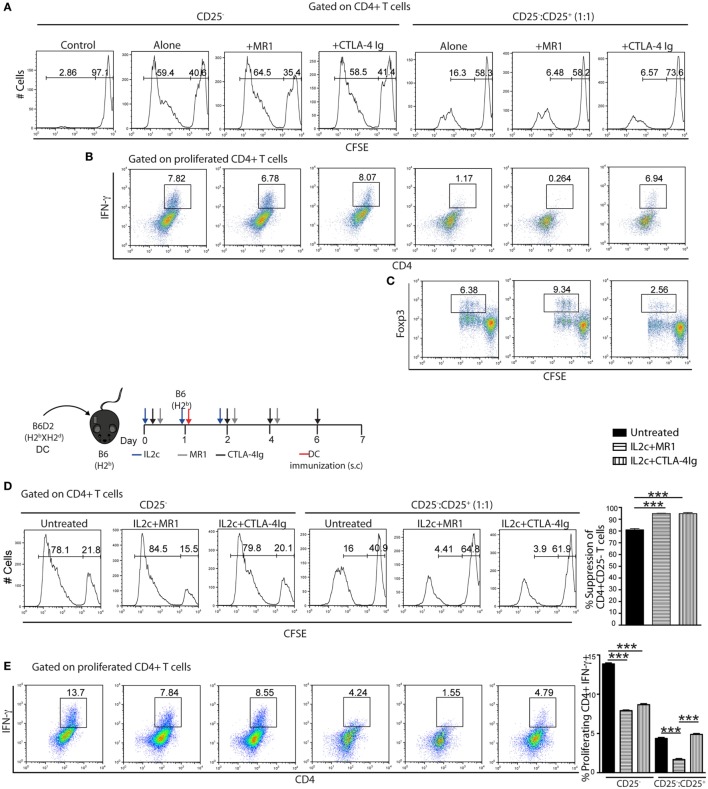
Suppressive function of IL2c-expanded Treg in the presence of co-stimulation blockade. (A–C) CD4+CD25− (CD25−) and CD4+CD25+ (CD25+) T cells were isolated from naïve B6 mice. CFSE-labeled CD25− cells (1 × 105) were cultured alone or 1:1 with unlabeled CD25+ in the presence of 0.2 × 105 allogeneic B6D2 dendritic cells (DC) and various drugs for 6 days. (D,E) B6 mice were immunized with 5 × 105 allogeneic B6D2 DC and either left untreated or received IL2c + MR1 or IL2c + CTLA-4 Ig. On day 7 after immunization, CD4+ T-cell subsets were isolated from pooled lymphoid organs and the CFSE-labeled CD25− subset was cocultured with CD25+ and B6D2 DC for 6 days before assessment by flow cytometry. (A,D) CFSE dilutions. (B,E) Frequency of IFN-γ+CD4+ proliferating T cells. (C) Foxp3 expression by CD4+ proliferating T cells. All in vitro conditions were plated in triplicates and data are shown from one out of two representative experiments. Bar graphs indicate mean ± SEM (***P < 0.001).